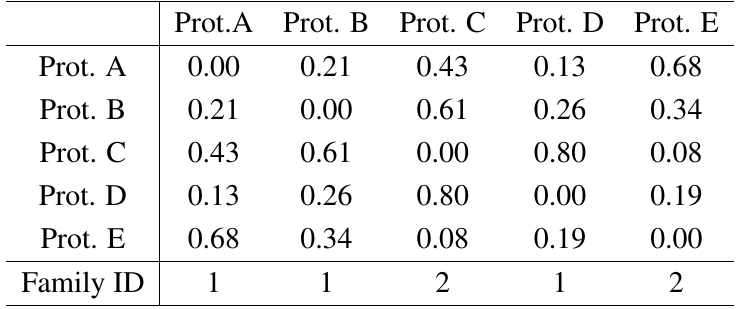
Table 1. Illustrative values assigned to optimal alignments from dynamic programming